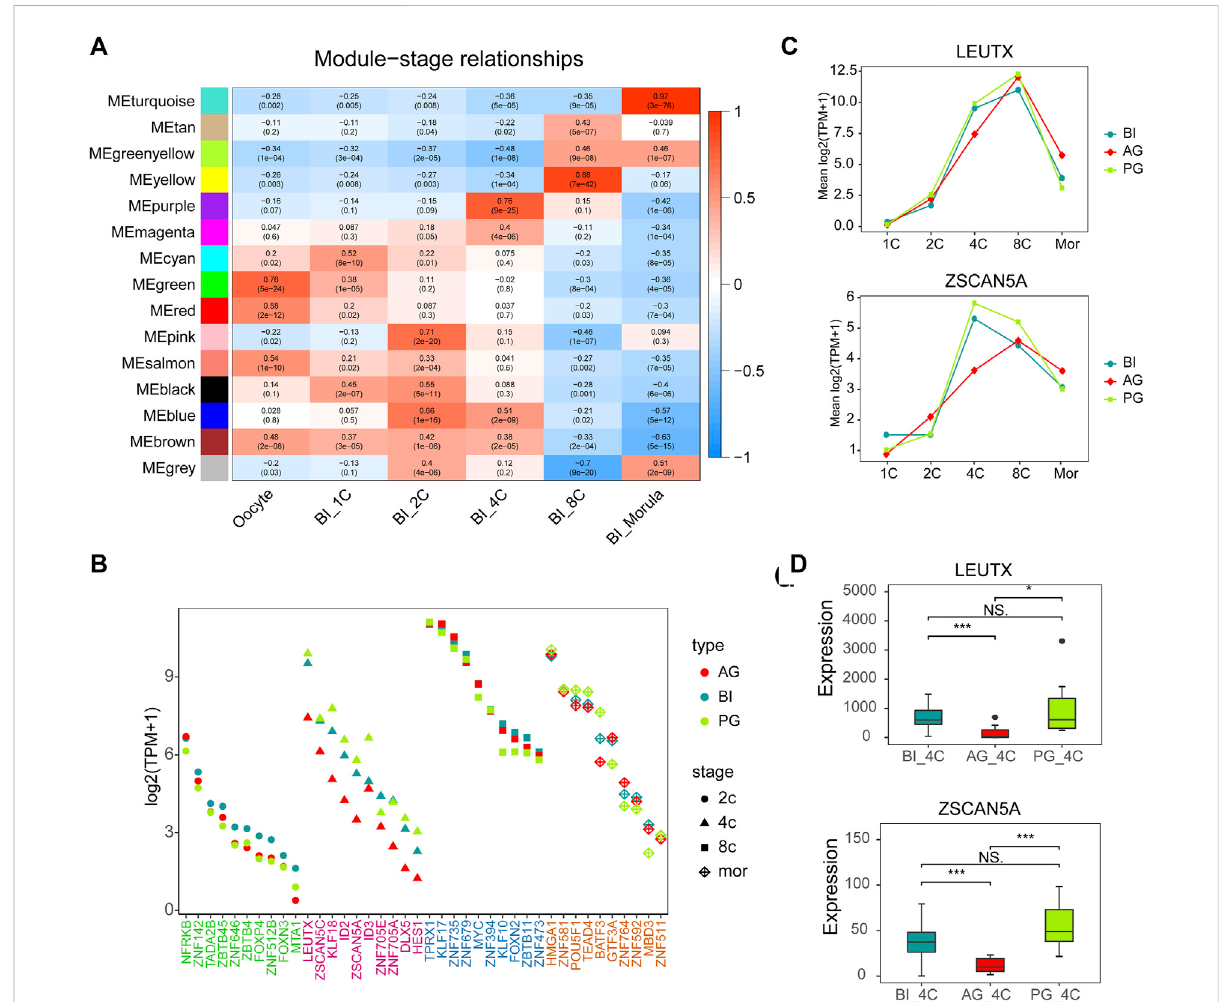
FIGURE 3 Gene co-expression network analysis in BI embryos and comparison of key TFs. (A) Heatmap showing relationships between modules and speci fi c stages. Each cell contains the value of correlation and p value. (B) Module visualization of network connections between all TFs in the pink, purple,yellow,turquoisemodulesandothergeneswhichshowahighpositivecorrelation(PC ≥ 0.7).HighlyconnectedintramodularhubTFs(top10) are indicated by a different color dot. (C) LEUTX and ZSCAN5A expression in each stage of three types of embryos. (D) The expression of ZSCAN5A and LEUTX in the three types of embryos at the 4-cell